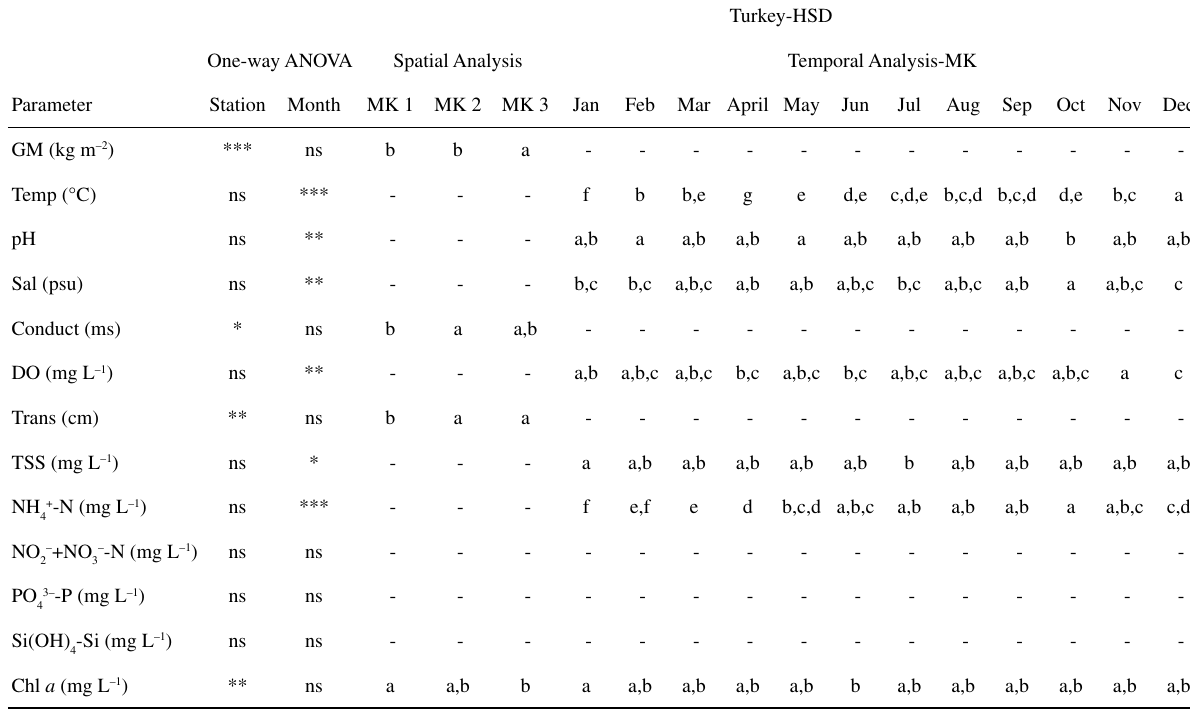
Table S3. – Spatial and temporal variation of green mussel production and seawater parameters in the mussel cultivation areas at the Meaklong River Mouth (MK) by using one-way ANOVA and